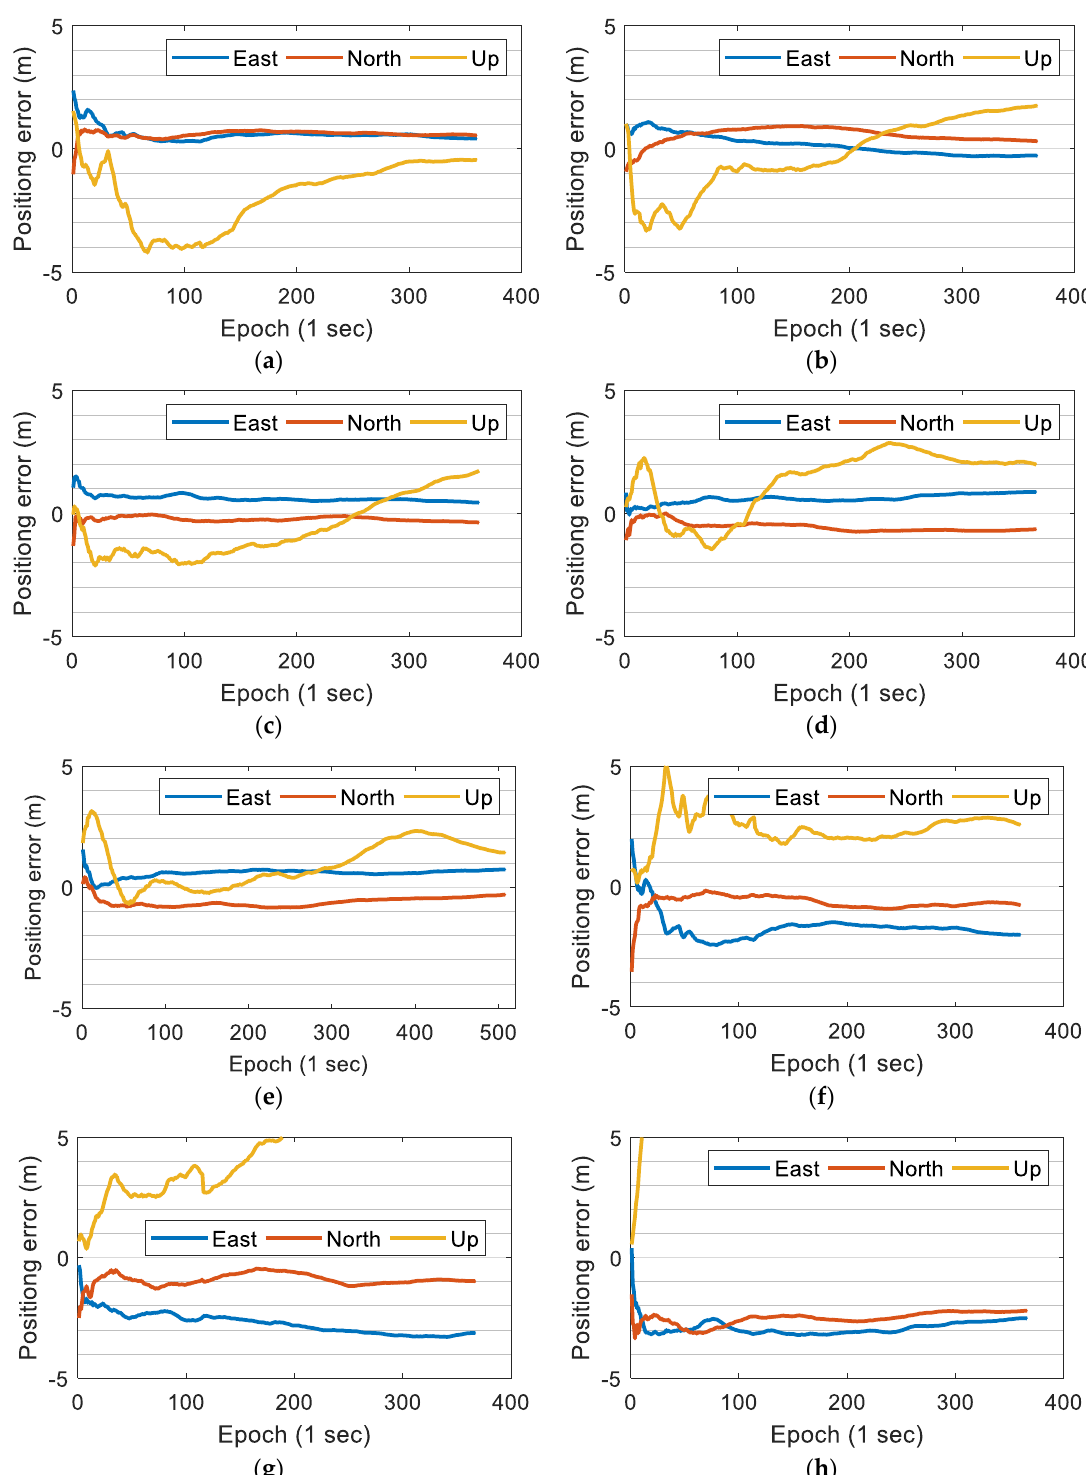
Figure 6. The North (N), East (E), and Up (U) direction errors of precise point positioning (PPP) positioning results of the five time periods. ( a ) 1st time period (G + C + E); ( b ) 2nd time period (G + C + E); ( c ) 3rd time period (G + C + E); ( d ) 4th time period (G + C + E); ( e ) 5th time period (G + C + E); ( f ) 1st time period (GPS); ( g ) 2nd time period (GPS); ( h ) 4th time period (GPS). The “G”, “C” and “E” denote GPS, BDS, and